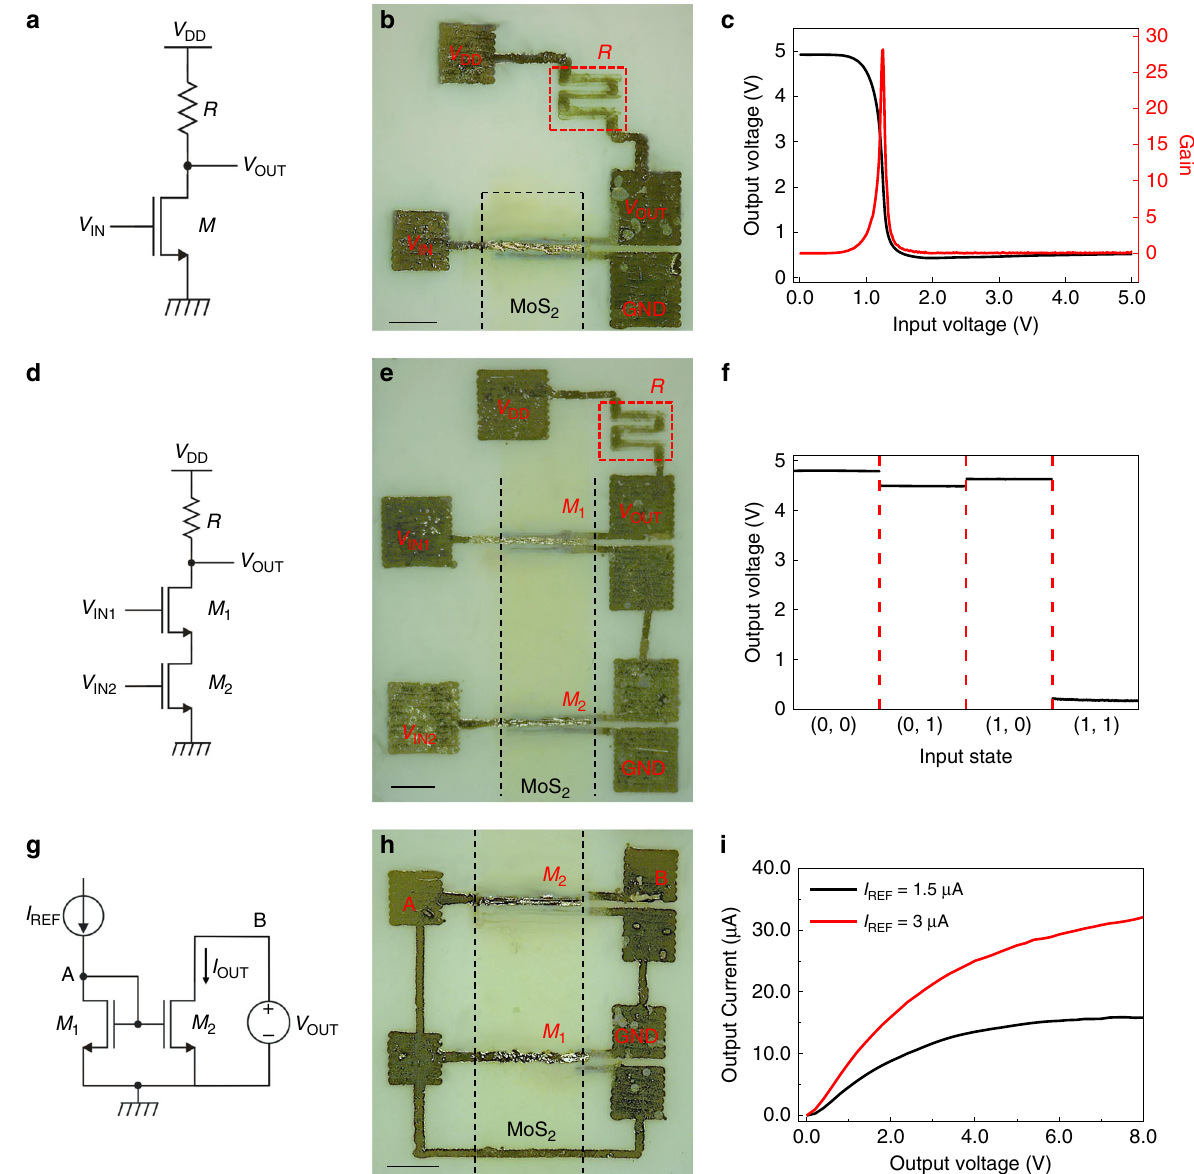
Fig. 4 Logic gates and current mirror based on inkjet-printed MoS 2 FETs. a Electrical schematic and b optical image of an inverter. c Output voltage (left axis) and voltage gain (right axis) of the inverter gate as a function of the input voltage. d Electrical schematic and e optical image of a NAND gate. f Output voltage of the NAND gate as a function of the input states ( V IN1 , V IN2 ). Voltage bias is 5 V for both the inverter and the NAND gate. g Electrical schematic and h optical image of a current mirror. i Output current of the current mirror as a function of the output voltage for two different values of the reference current. Legend: V DD , supply voltage; GDN, ground reference; V IN and V OUT , input and output voltage; M , inkjet-printed transistor. R , inkjet-printed graphene resistor. The scale bars in b , e , h correspond to 250 μ